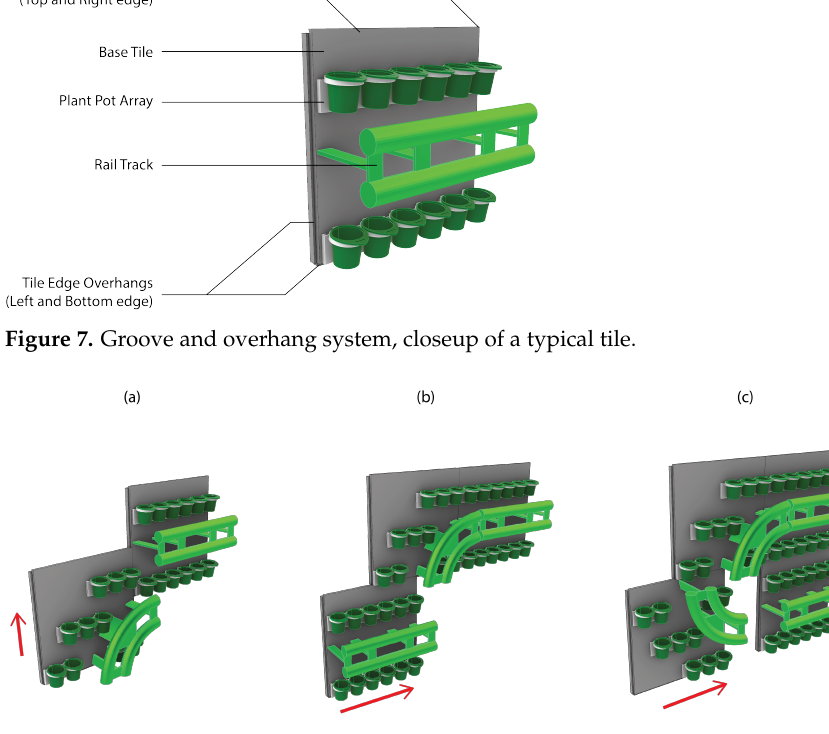
Figure 8. Installation process of modular green wall tiles, ( a ) Initial tile to be placed at top right corner of intended track surface, ( b ) Subsequent tiles are added from right to left, then from top to bottom due to design of overhangs and grooves, ( c ) Sequence of installation has to be done beforehand to ensure correct and continuous track path